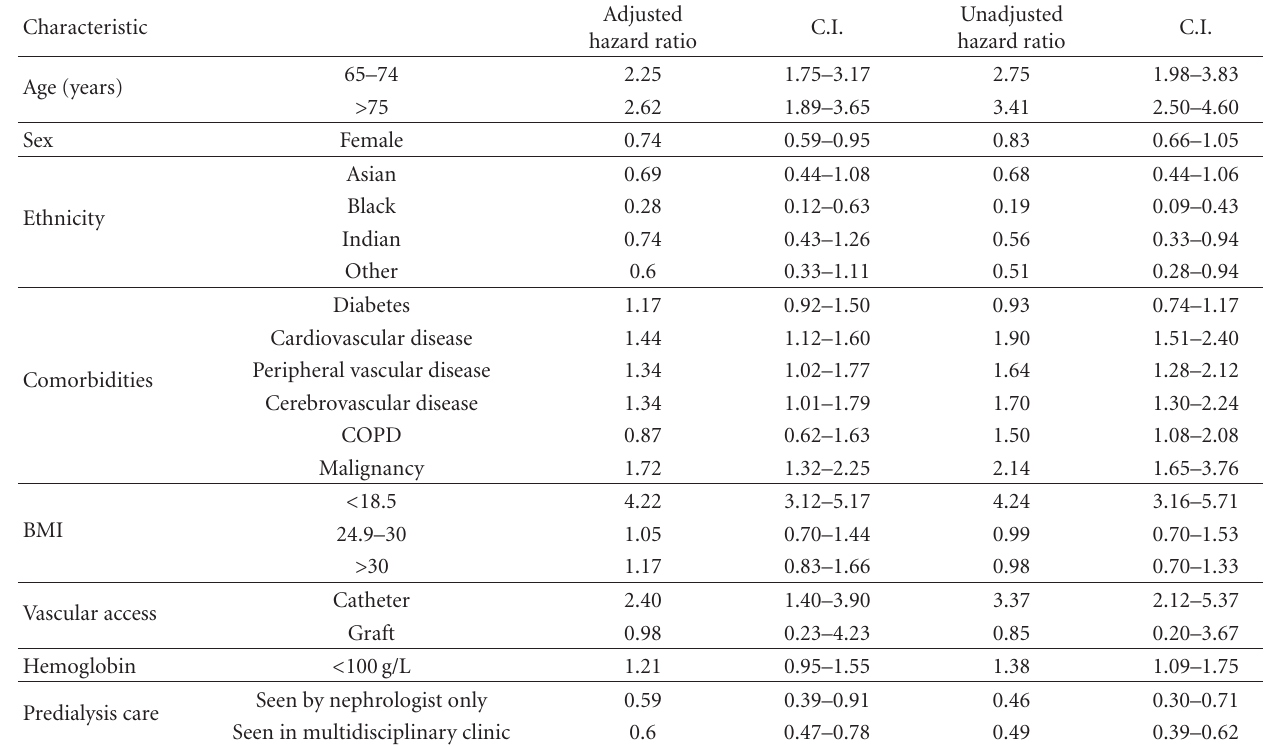
Table 2: Risk factors for mortality.